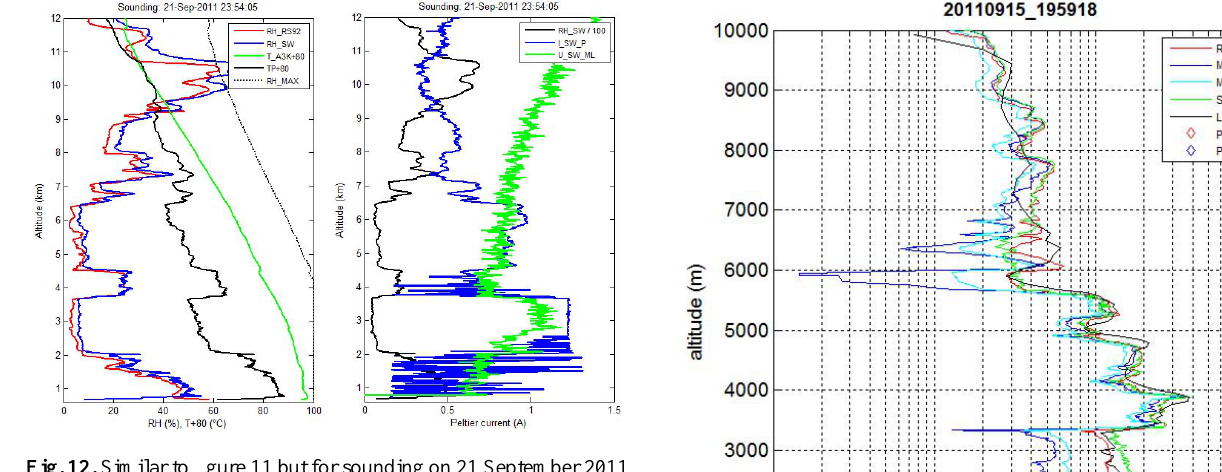
Fig. 12. Similar to figure 11 but for sounding on 21 September 2011 at 23:54UTC. Snow White sensor was a C34/040 “daytime” ver- sion.